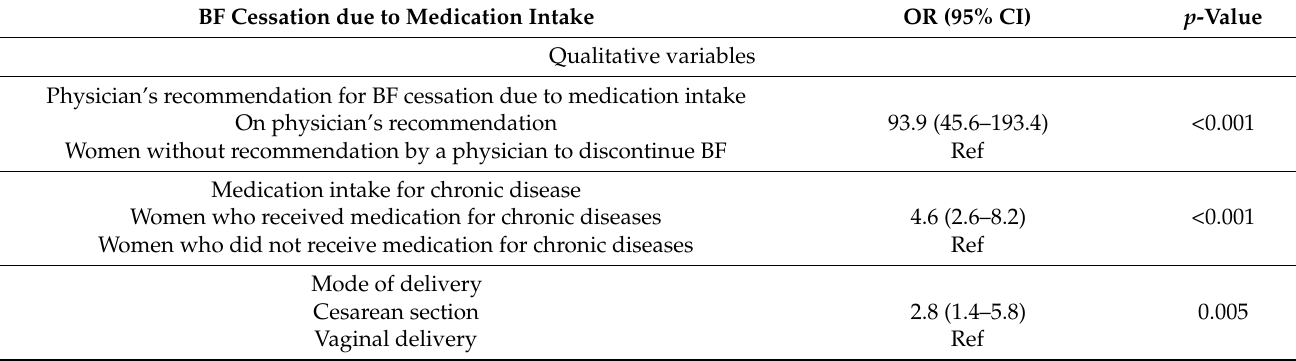
Table 1. Univariate logistic regression analysis for breastfeeding cessation due to medication intake. (Attica/Greece 2020; n =